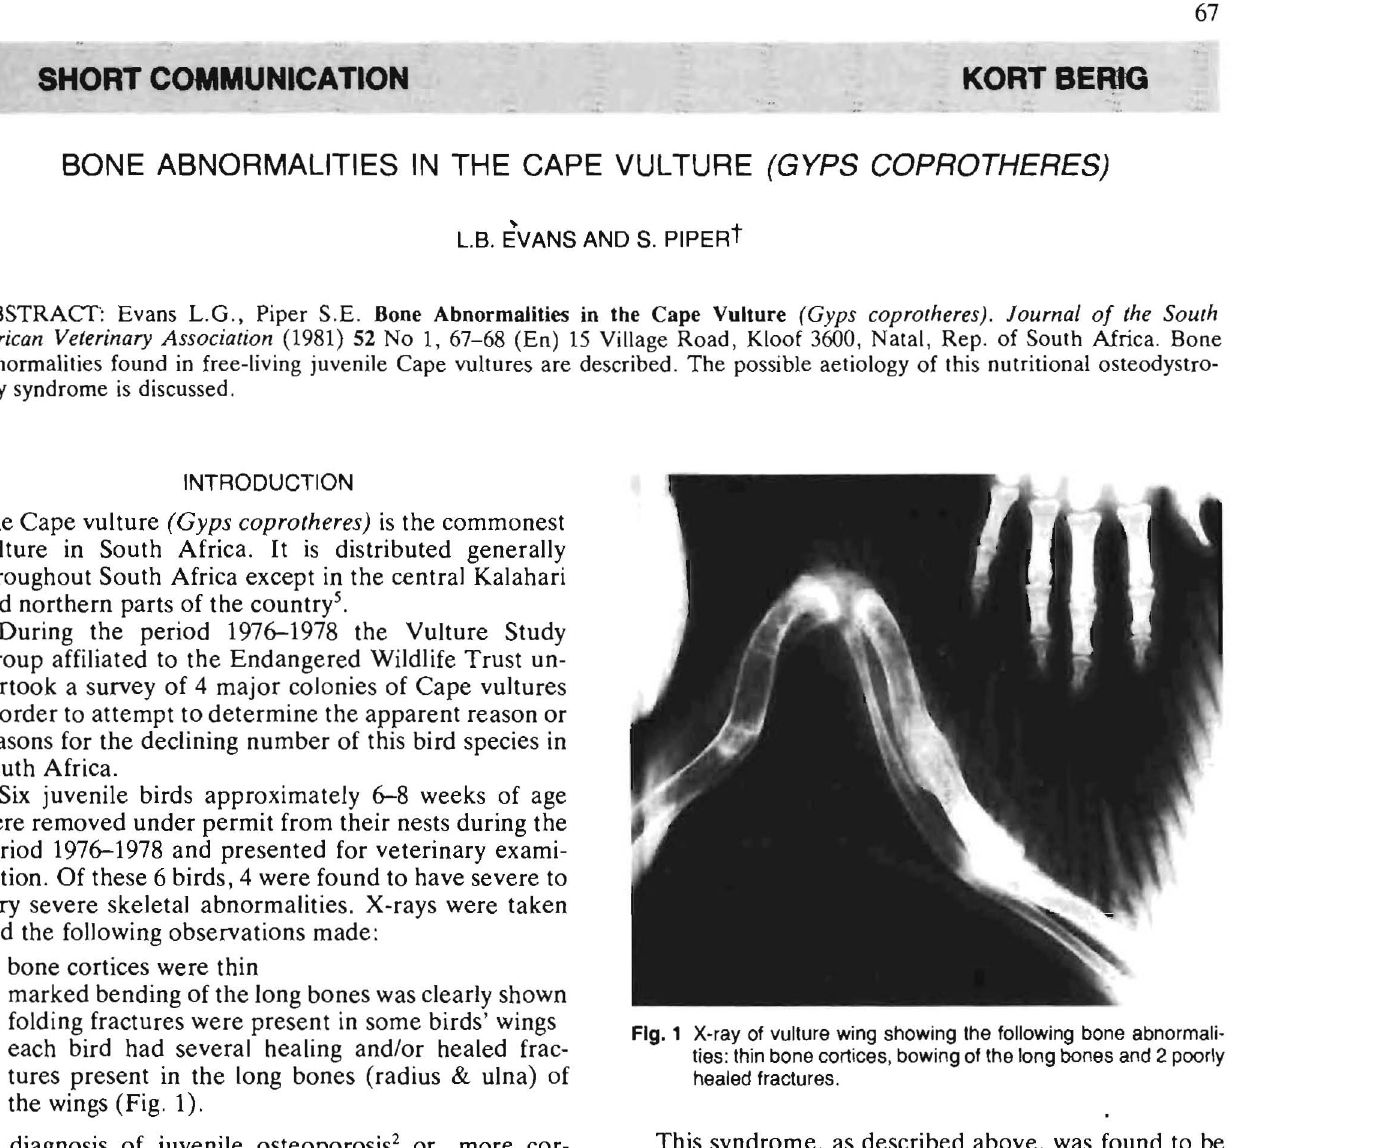
Fig. 1 X-ray of vulture wing showing the following bone abnormali ties: thin bone cortices, bowing of the long bones and 2 poorly healed